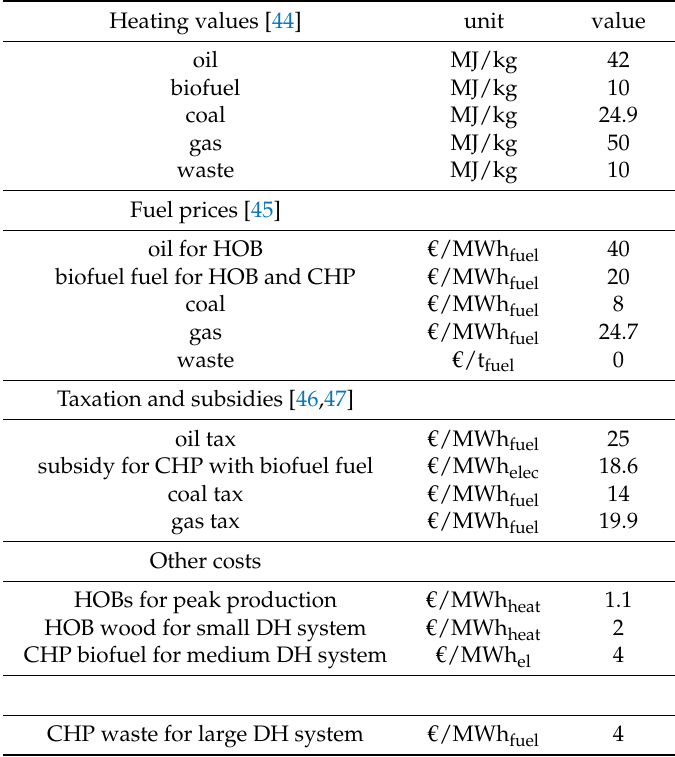
Table A2. Technical and economical input values used in